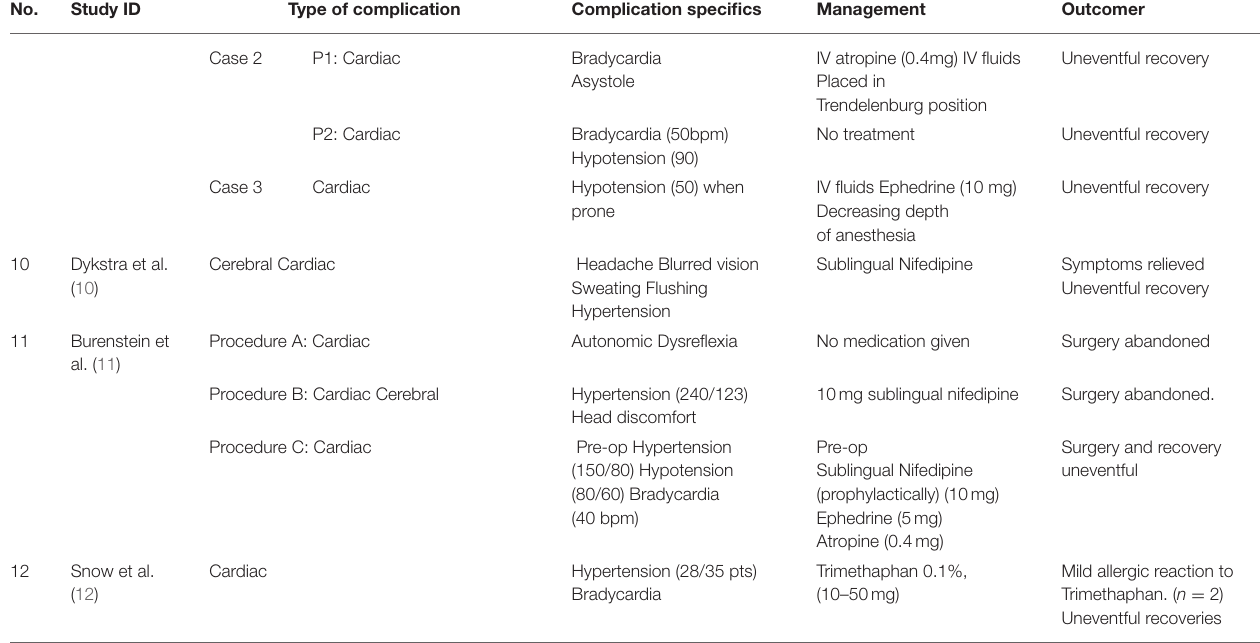
TABLE 4 | Complications organized by categories: cardiac, pulmonary, cerebral and others. Cardiac complications (# of studies reported)